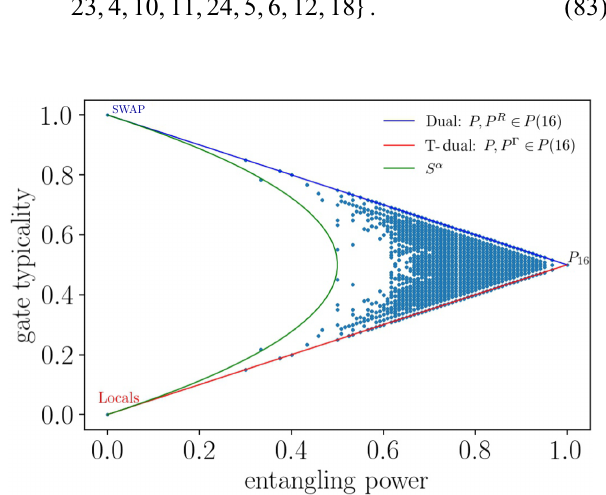
FIG. 12. The two-ququad case d 2 = 16. The entangling power versus the gate typicality of 1.2 × 10 7 permutations (out of a total of 16! ≈ 10 13 permutations), treated as two-ququad gates. the number of entangling classes corresponding to dual (and, equiva- lently, T-dual) permutation matrices obtained from our numerical search is found to be 56.